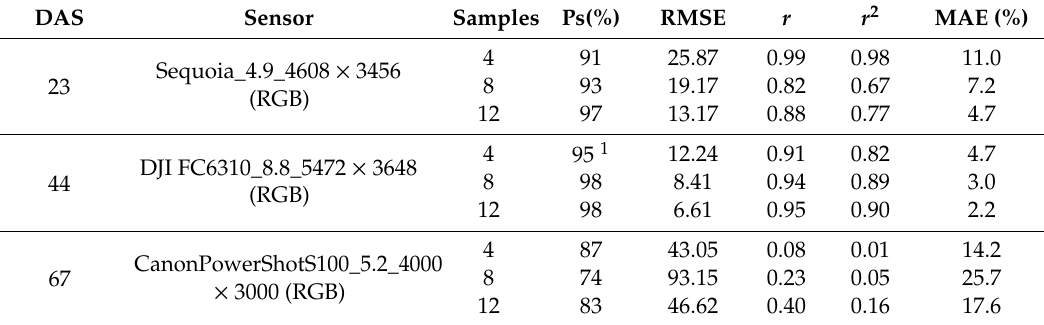
Table 3. Results between counting through the normalized cross-correlation and manual counting for the different cameras used during the corn growing season showing precision in the estimation (Ps), root mean square error (RMSE), correlation coefficient ( r ), determination coefficient ( r 2 ) and mean absolute error (MAE).